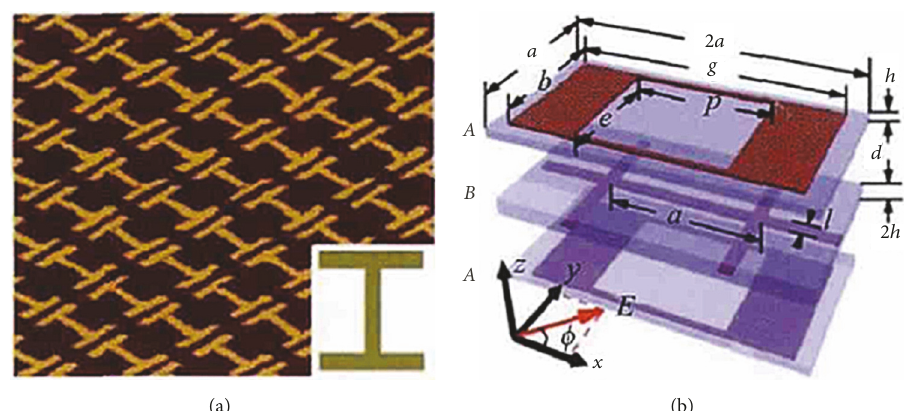
Figure 14: Polarization was controlled by reflection and transmission of metasurface structure. (a) Image of part of the experimental sample. (b) Geometry of the model